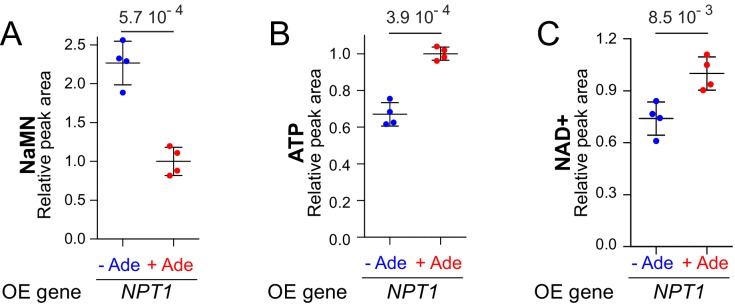
Accumulation of NaMN in response to NPT1 overexpression is higher when ATP is limiting.Wild-type cells (BY4742) were transformed with a plasmid allowing overexpression (OE) of the NPT1 gene. Transformants were grown in SDcasaWU medium lacking (blue dots) or not (red dots) adenine. Values obtained with the empty vector were set at 1. Quantifications were determined from independent metabolite extractions (N = 4). Standard deviation is presented and indicated p-values were calculated using a Welch’s t-test.10.7554/eLife.43808.050Figure 7—figure supplement 2—source data 1.Metabolic analyses for the wild-type overexpressing NPT1 and grown in ±adenine.